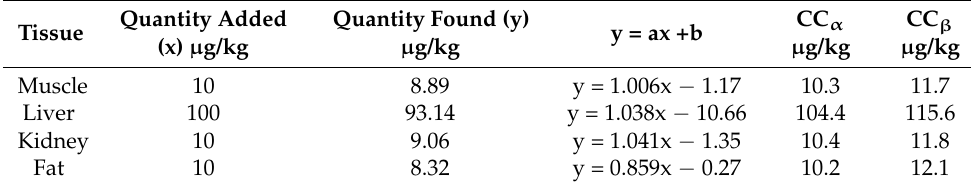
Table 4. The determination of levamisole